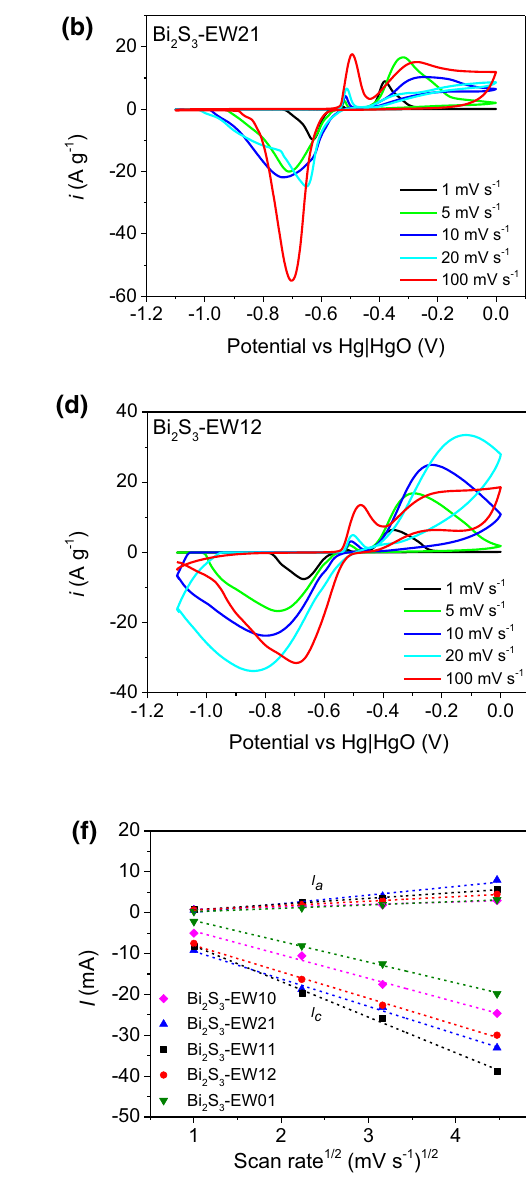
Fig. 5 Cyclic voltammograms of bismuth sulfides synthesized from different mixtures of ethanol and water ( a – e ) and variation of anodic and cathodic peak currents with the square root of scan rates ( f